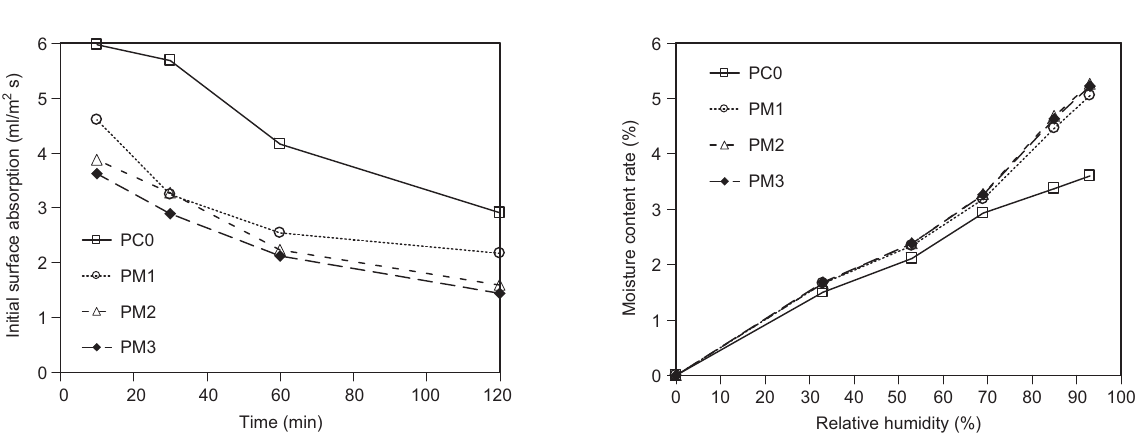
Figure 6 Adsorption isotherms of cement pastes within various RHs vs. the montmorillonite